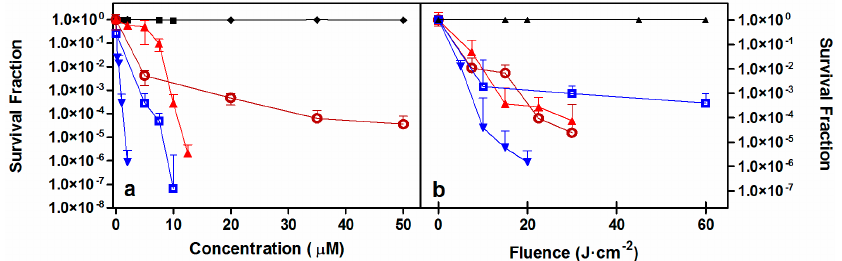
Figure 3. Photoinactivation studies against S. aureus (filled blue inverted triangles) E. coli (open blue squares), C. krusei (filled red triangles) and C. albicans (open red circles). Concentration-dependent ( a ) and light-dependent ( b ) survival curves for compound 2 . Controls: No light (black diamonds). No PS (black triangles). Solid lines connecting data series are provided only for visualization purposes. Fluences: 20 J·cm − 2 for S. aureus , 60 J·cm − 2 for E. coli and 22.5 J·cm − 2 for both Candida species , respectively. PS concentrations: 2 μ M against S. aureus ; 5 μ M against E. coli; 10 μ M against C. krusei , and 35 μ M against C. albicans .